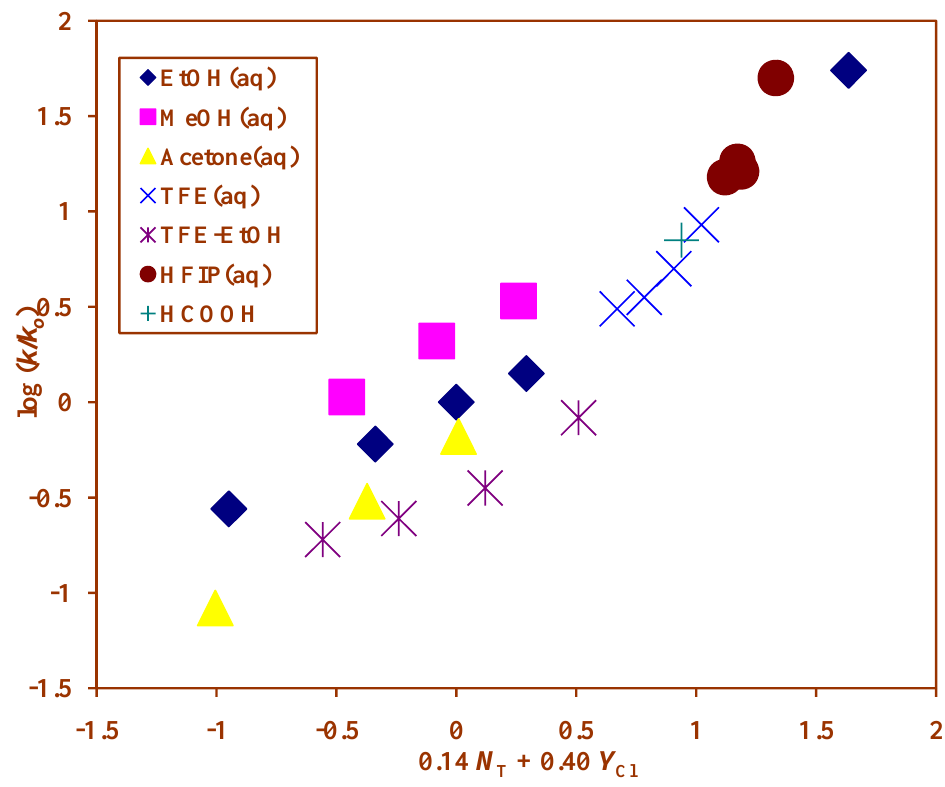
Figure 2. The plot of log ( k/k chloroformate ( 1) in pure and binary solvents at 25.0